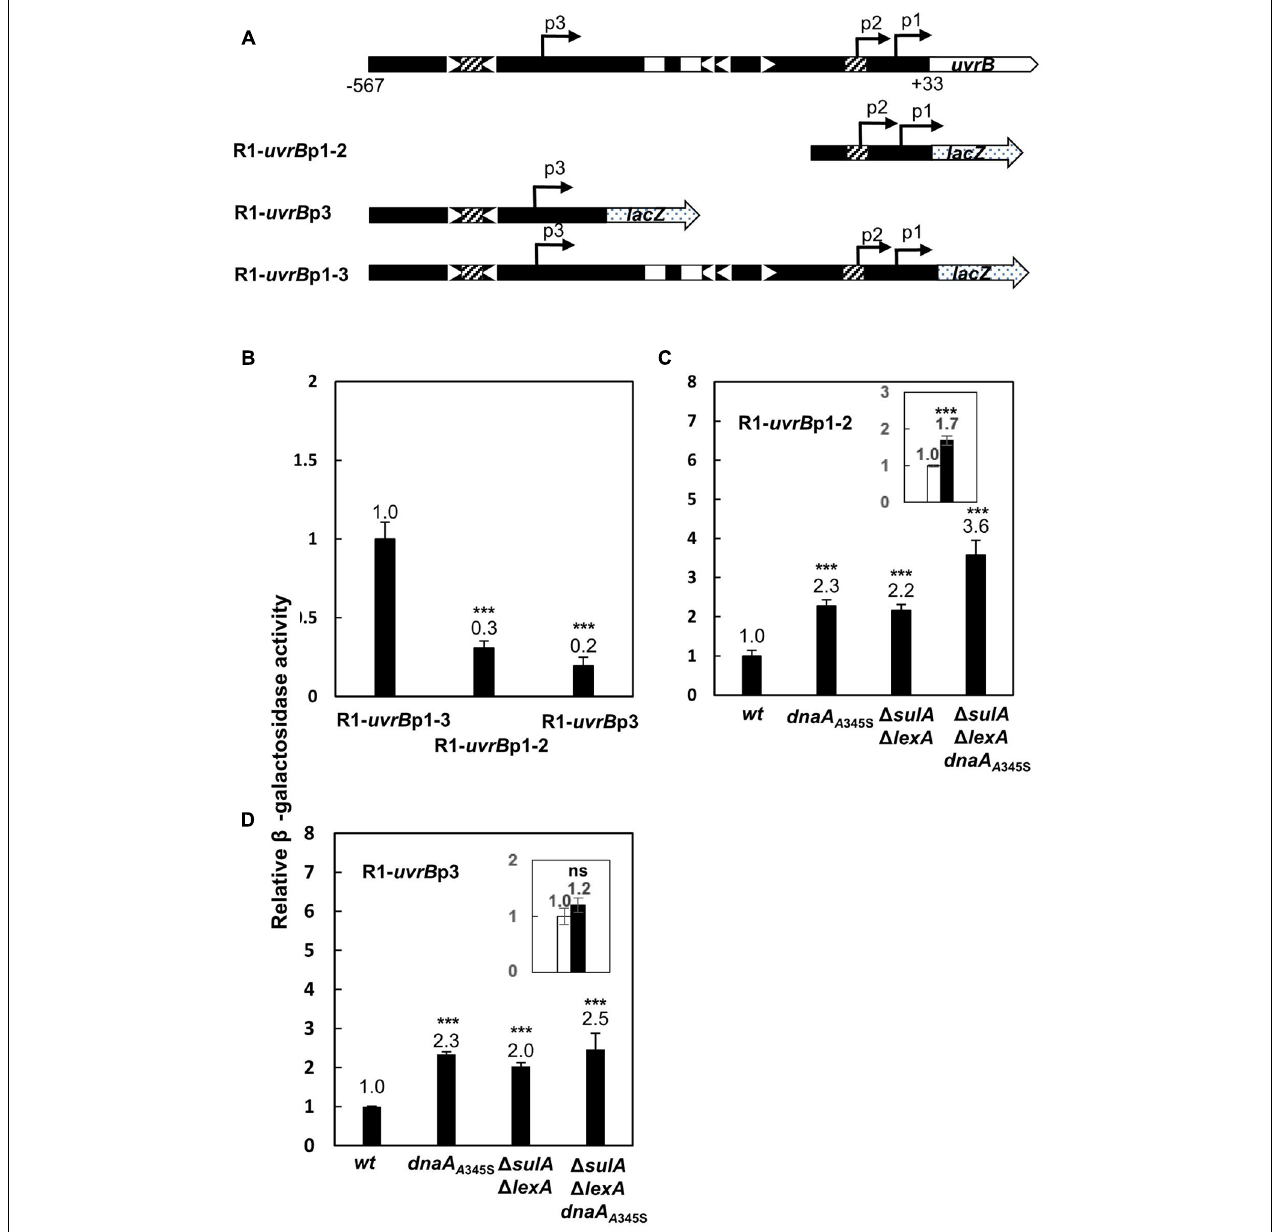
FIGURE 4 | The full activity of the uvrB promoter requires the uvrB p1-2 and uvrB p3 promoters. (A) Illustration for insertion of individual uvrB promoter in front of the lacZ gene into MiniR1 plasmid. Construction of the MiniR1- uvrB p1-3- lacZ (R1- uvrB p1-3), MiniR1- uvrB p1-2- lacZ (R1- uvrB p1-2) or MiniR1- uvrB p3- lacZ (R1- uvrB p3) plasmid was as mentioned in section “Materials and Methods.” Promoter uvrB p1-2 contains promoter 1 and 2, ranging from –77 to +33; promoter uvrB p3 starts from –567 and ends at –280; Promoter uvrB p1-3 consists of promoter 1, 2, and 3, including the region from –567 to +33, the whole cluster of the uvrB promoters. The nucleotide positions are as indicated in Figure 2 . The gray arrows represent the lacZ gene. The open rectangles represent LexA-boxes, the open triangles represent DnaA-boxes with orientation, the hatched rectangles represent LexA-boxes overlapping with DnaA-box. The filled arrows indicate positions of the promoters and orientation of transcriptions. The p1, p2, and p3 represent the uvrB promoter 1, 2, and 3. The wild-type, dnaA A345S , (cid:49) sulA (cid:49) lexA and (cid:49) sulA (cid:49) lexA dnaA A345S cells were transformed by plasmid R1- uvrB p1-3, R1- uvrB p1-2, and R1- uvrB p3, respectively. The resultant transformants were exponentially grown in ABTGcasa medium at 37 ◦ C. Activity of the individual plasmid-borne uvrB promoter was measured as the β -galactosidase activity in the cells by Miller method (Miller, 1972). Activity of individual promoter relative to that of R1- uvrB p1-3 (229 U) in the wild-type cells is illustrated (B) . Relative activity of promoter R1- uvrB p1-2 (C) , or R1- uvrB p3 (D) in the dnaA A345S , (cid:49) sulA (cid:49) lexA and (cid:49) sulA (cid:49) lexA dnaA A345S cells compared with that in the wild-type cells (70 U for uvrB p1-2 and 44 U for R1- uvrB p3) is illustrated. The insets indicate the relative activity of promoters in the (cid:49) sulA (cid:49) lexA dnaA A345S cells against that in the (cid:49) sulA (cid:49) lexA cells. The values shown at top of the bars are the average of three individual experiments, and the standard errors are shown. ∗∗∗ Stands for P -value ≤ 0.01, ∗∗ for 0.01 < P -value ≤ 0.05, and ns represents P -value >